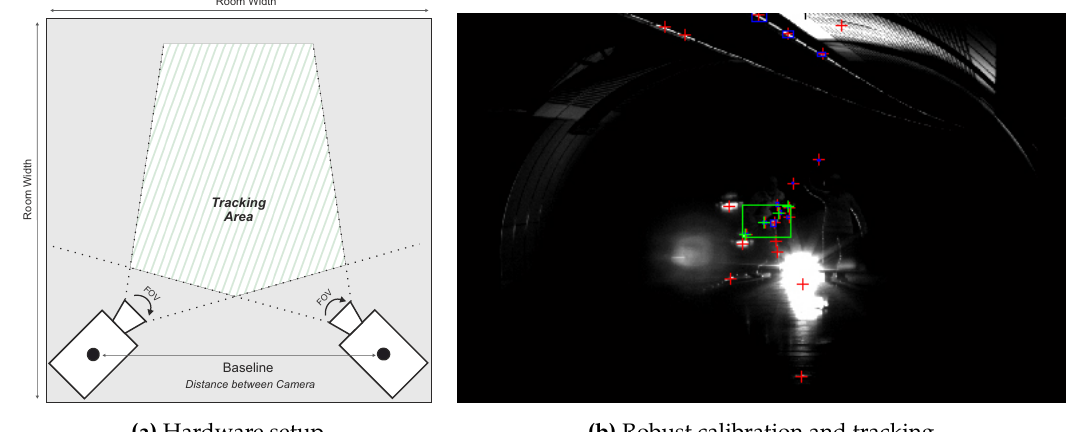
Figure 1. Key properties of the presented optical tracking